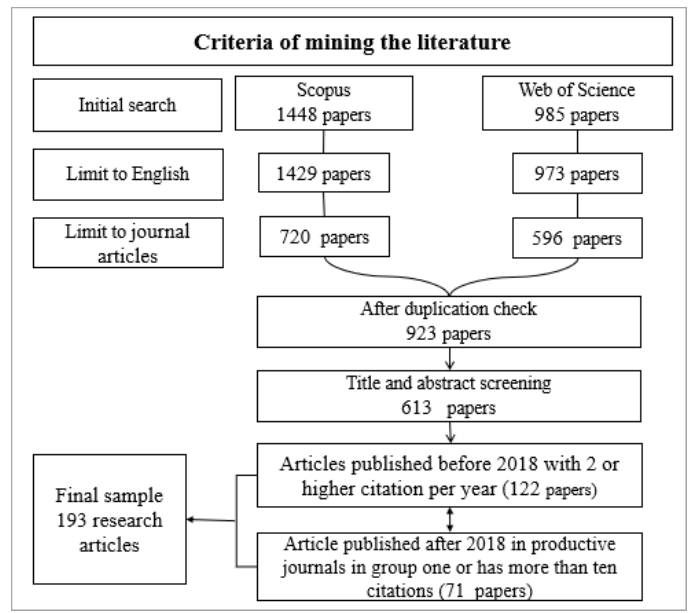
Figure 1. The flow chart of the data collection.